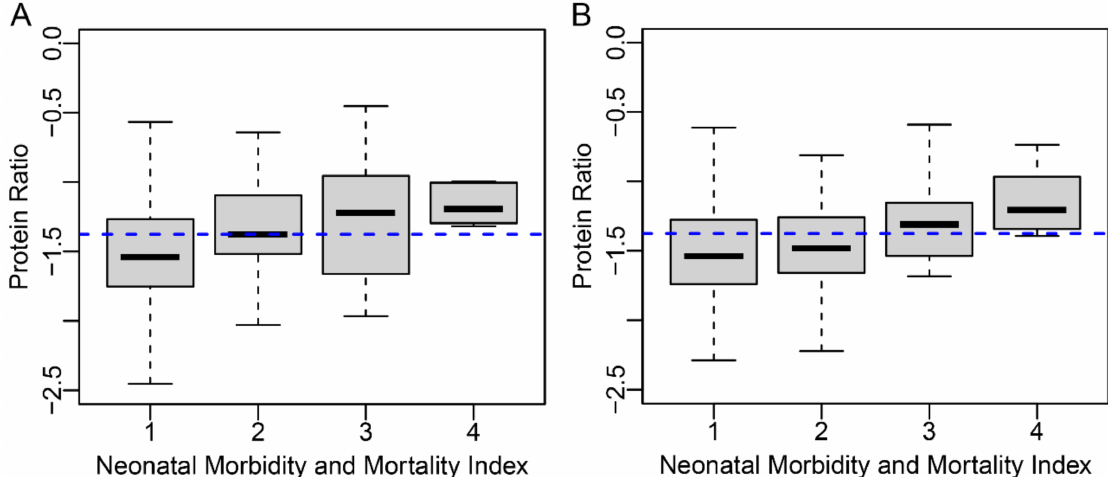
Figure 3. Distribution of all subjects by test score and NMI index. NMI distribution by proteomic biomarker in verification phase subjects from the PAPR study ( A ) and in validation phase subjects from the TREETOP study ( B ) are represented by box plots (box, interquartile range; line, mean; whiskers, remaining range of scores to a maximum of 1.5 box widths). The blue dashed line indicates the proteomic biomarker threshold of −